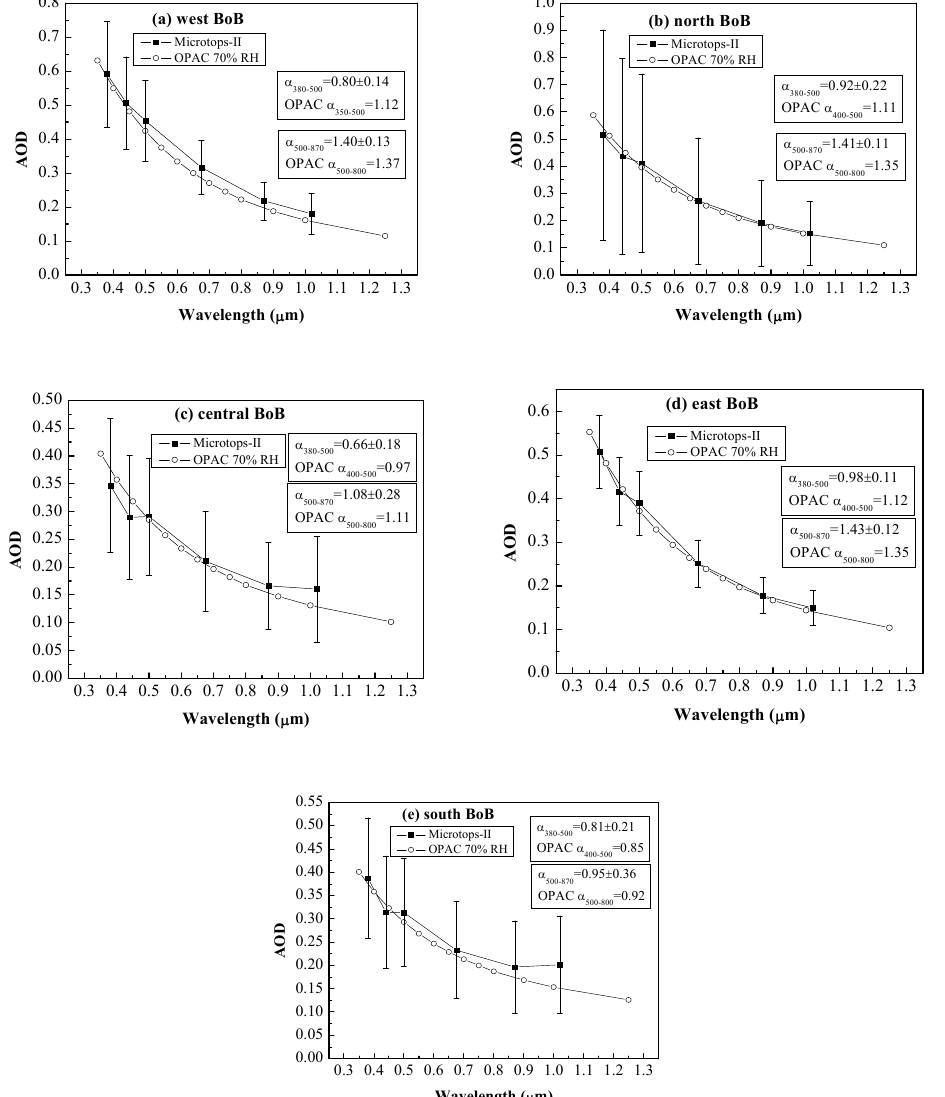
Fig. 14. Measured and OPAC-simulated (at 70% RH) spectral AOD over 5 BoB sub-regions. The vertical bars express one standard deviation from the regional mean AOD